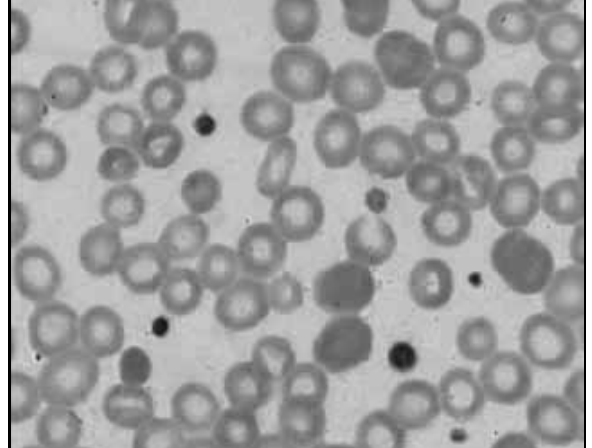
Figura – Distensão sanguínea corada com May-Grünwald-Giemsa (1.000x) mostrando macroplaquetas em um paciente com VPM de 12 fL VPM: volume plaquetário